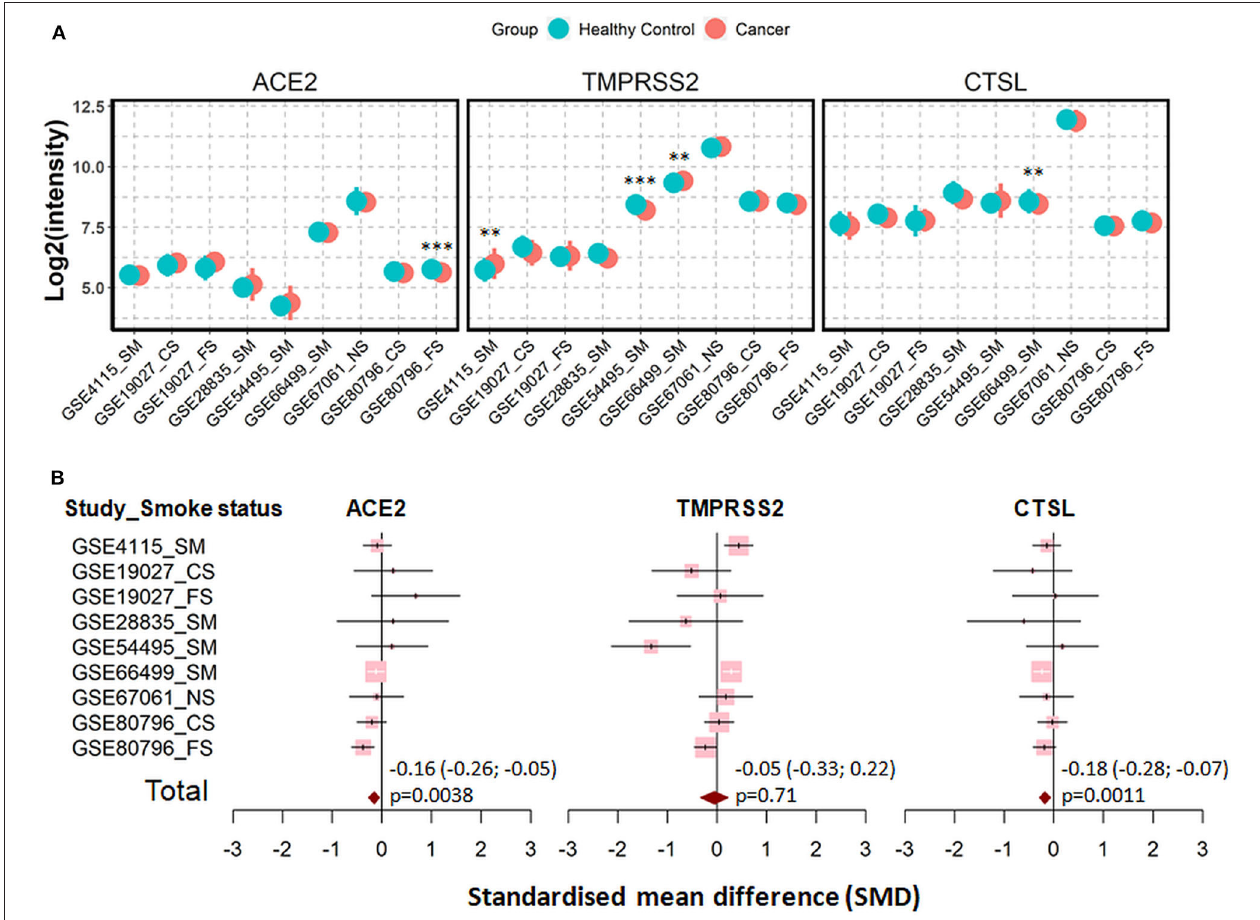
FIGURE 6 | Expression of ACE2, TMRPSS2, and cathepsin L (CTSL) in airway epithelial cells of healthy controls and patients with lung cancer. (A) Plot of expression levels of ACE2, TMPRSS2, and CTSL in nine datasets which contain healthy control and patients with lung cancers. Statistical difference was calculated by Student’s t -test. ** p < 0.01, *** p < 0.001. (B) Forest plot of nine datasets examining expression of ACE2, TMPRSS2, and CTSL in healthy controls and patients with lung cancer. The x-axis indicates the standardized mean difference (SMD), while the y-axis shows GEO datasets and cell types. The SMD, 95% CI and p -values